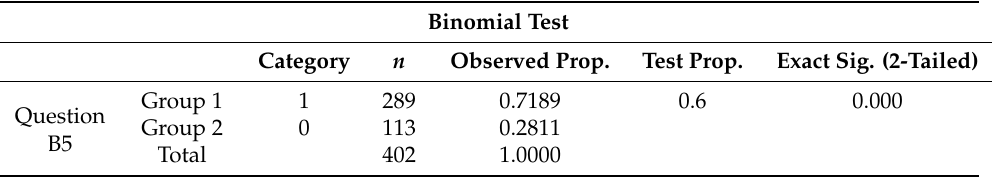
Table 2. Binomial test results for the hypothesis H1—WFEs. Category n Observed